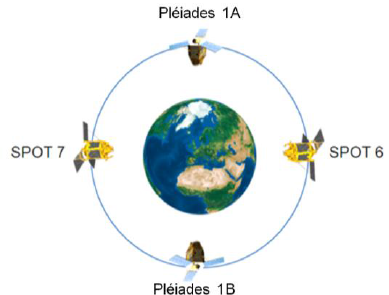
Figure 1. Pléiades 1A/1B & SPOT 6/7 Constellation (Astrium-GEO